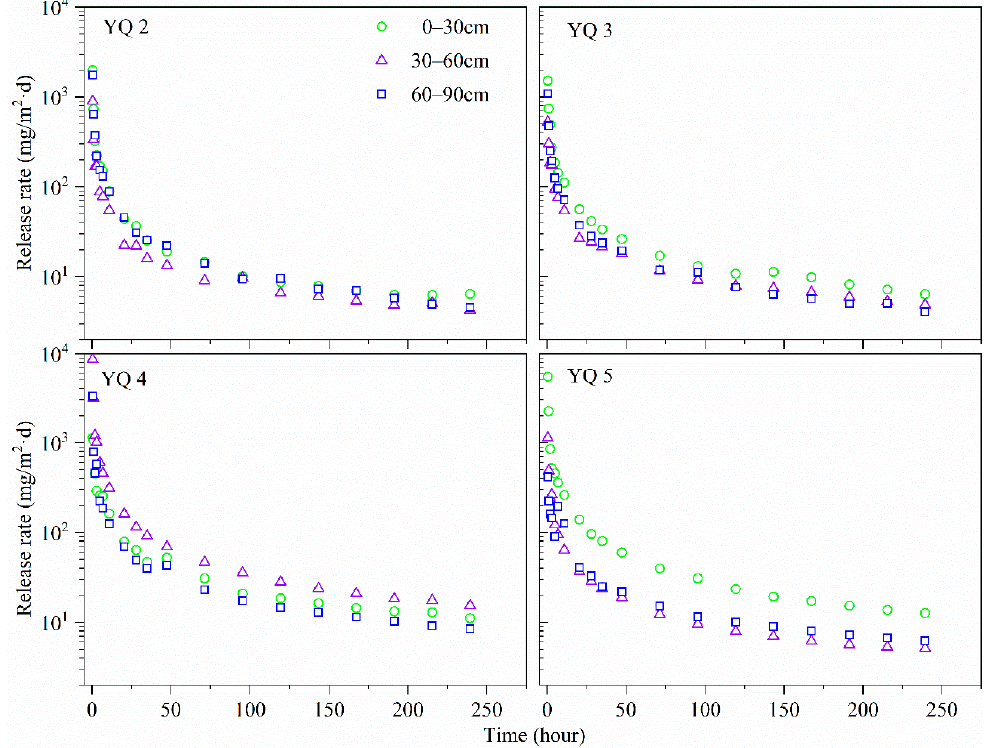
Figure 6. Time series of P release rate from four sediment cores and three different sediment depths.